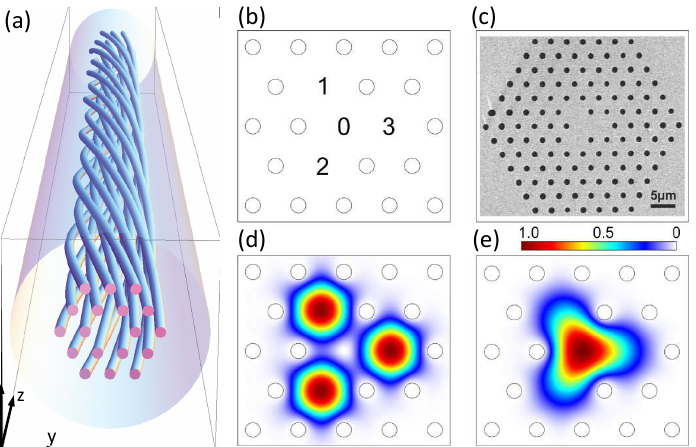
Figure 8. ( a ) The perspective of a helical PCF in a twisting period (blues rods are the air-holes passing through the silica fiber). Adapted with permission from Ref. [62] © AAAS. ( b ) Schematic structure of a Y-shaped core PCF. ( c ) Scanning electron micrograph of the Y-shaped core PCF. ( d ) Calculated axial Poynting vector of a ring mode at the wavelength of 800 nm in the fiber with a twist rate of 1.26 rad/mm. ( e ) Calculated axial Poynting vector of the fundamental mode which carries no OAM modes. Adapted with permission from Ref. [38] © The Optical